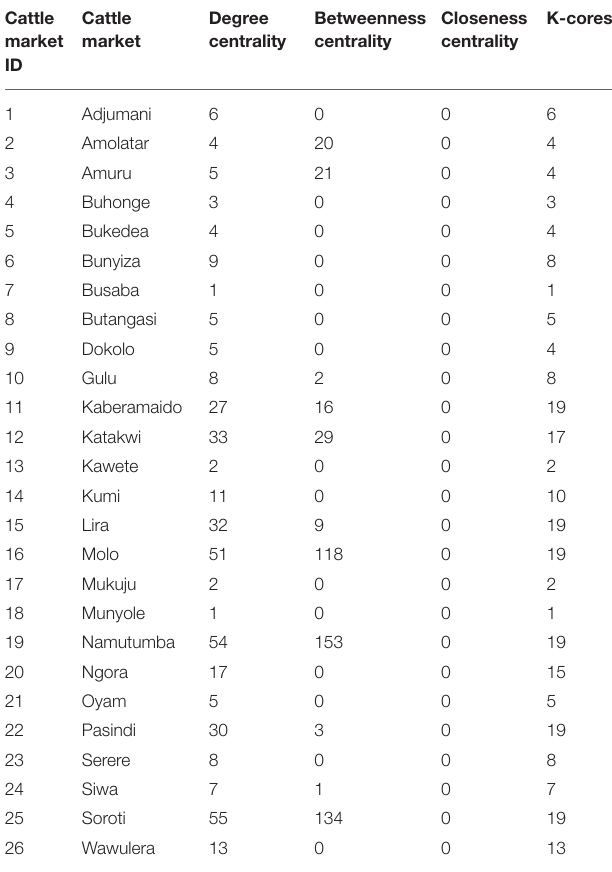
TABLE 2 | Cattle trade network metrics in southeast and northwest Uganda.